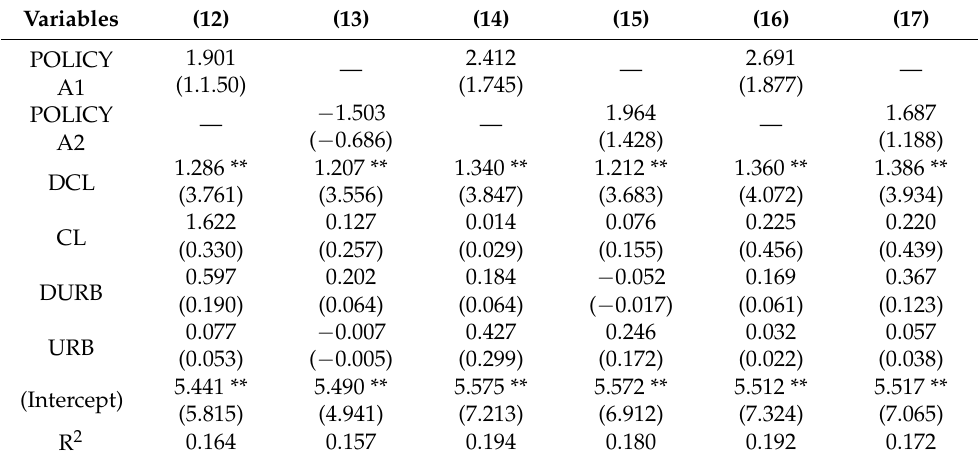
Table 7. Robustness test: time effects.